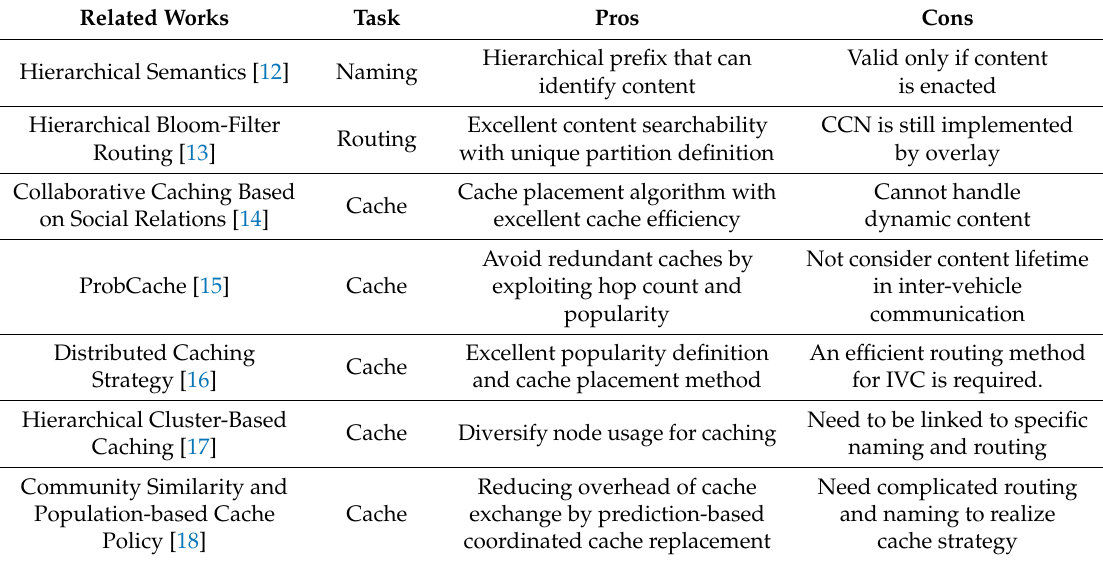
Table 1. Comparison of related works.